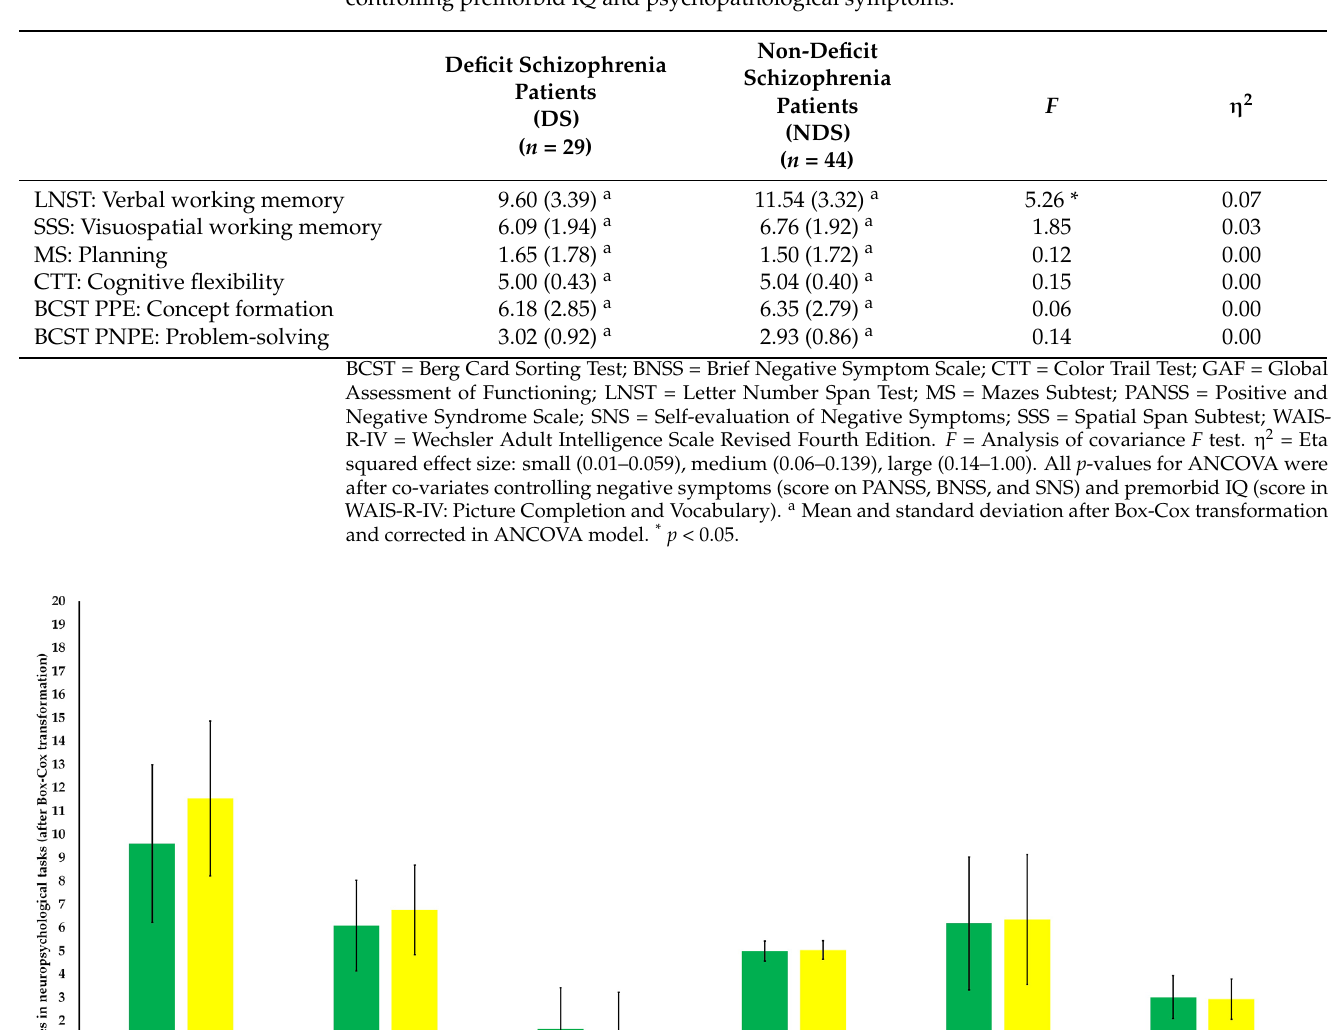
Table 3. Comparison of different aspects of executive functions between the two patient groups, controlling premorbid IQ and psychopathological symptoms.